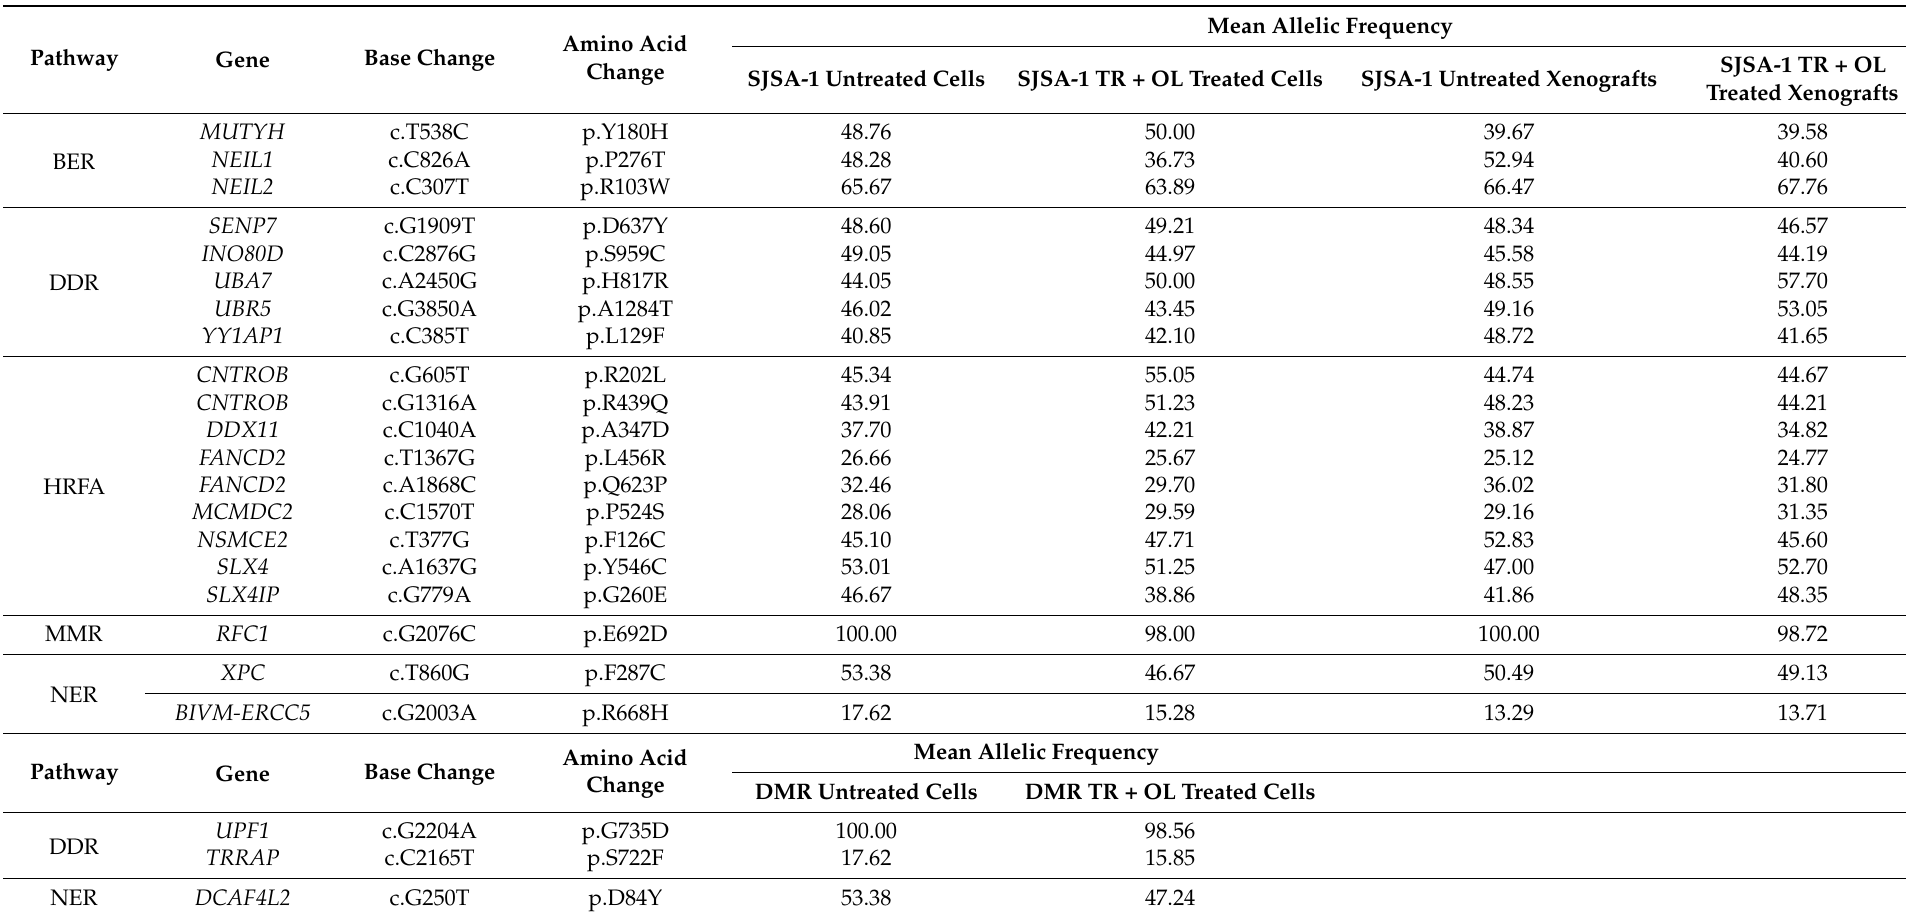
Table 3. DDRR genes in sarcoma cells and tumor samples from patients affected by nonsynonymous “probably damaging” mutations as predicted by the PolyPhen-2 tool. WES